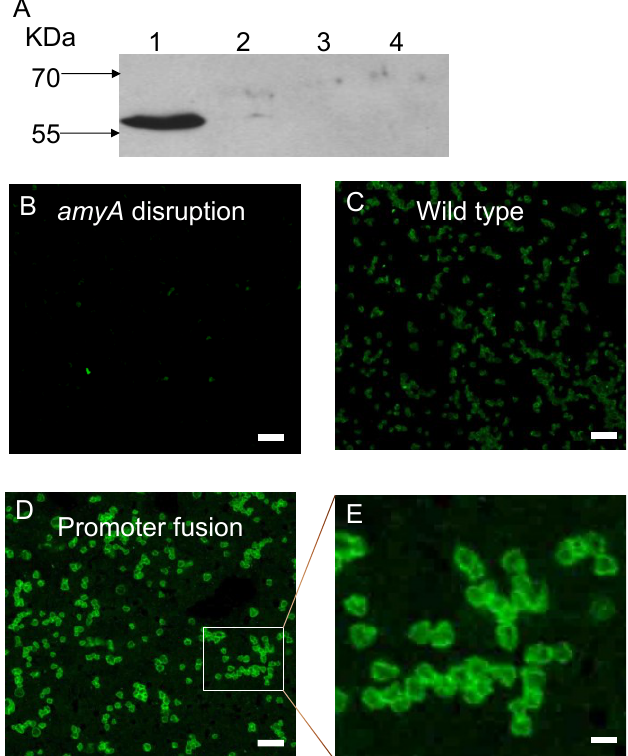
Figure 7. Panel A , Western blot analysis of β-glycosidase (LacS) from S. solfataricus wild-type strain, 98/2. Samples were: cytoplasmic fractions (Lane 1), membrane fractions (Lane 2), S-layer fractions (Lane 3); and supernatant (Lane 4). Samples were loaded in an amount equivalent to 1.0 OD 540 of cells. The western blot was probed with a 1:5000 dilution of the anti-LacS antibody, followed by a 1:5000 dilution of HRP goat anti-rabbit IgG secondary antibody. Immunofluorescence analysis of cell-associated α-Amylase. Fixed cells were treated with anti-α-Amylase antibodies conjugated to Alexafluor dye. Panel B . Cells lacking the α-amylase gene. Panel C . Wild type cells. Panel D . Cells encoding the α-amylase promoter fusion. Panel E . Inset of panel C. Bars in Panels A–C 5 microns, bar in panel D 0.5